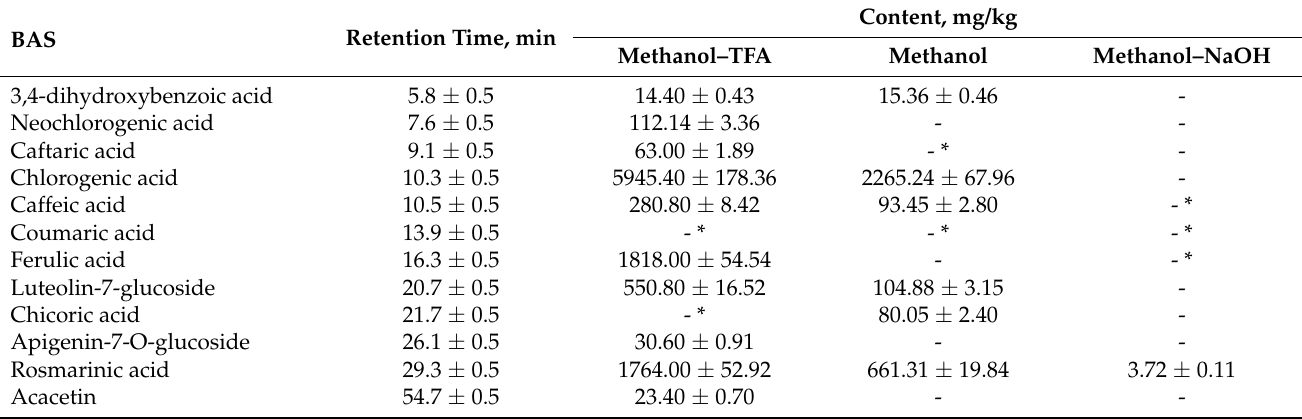
Table 2 lists the BASs identified in the T. vulgare extract samples. Table 2. Amount of biologically active substances identified in T. vulgare